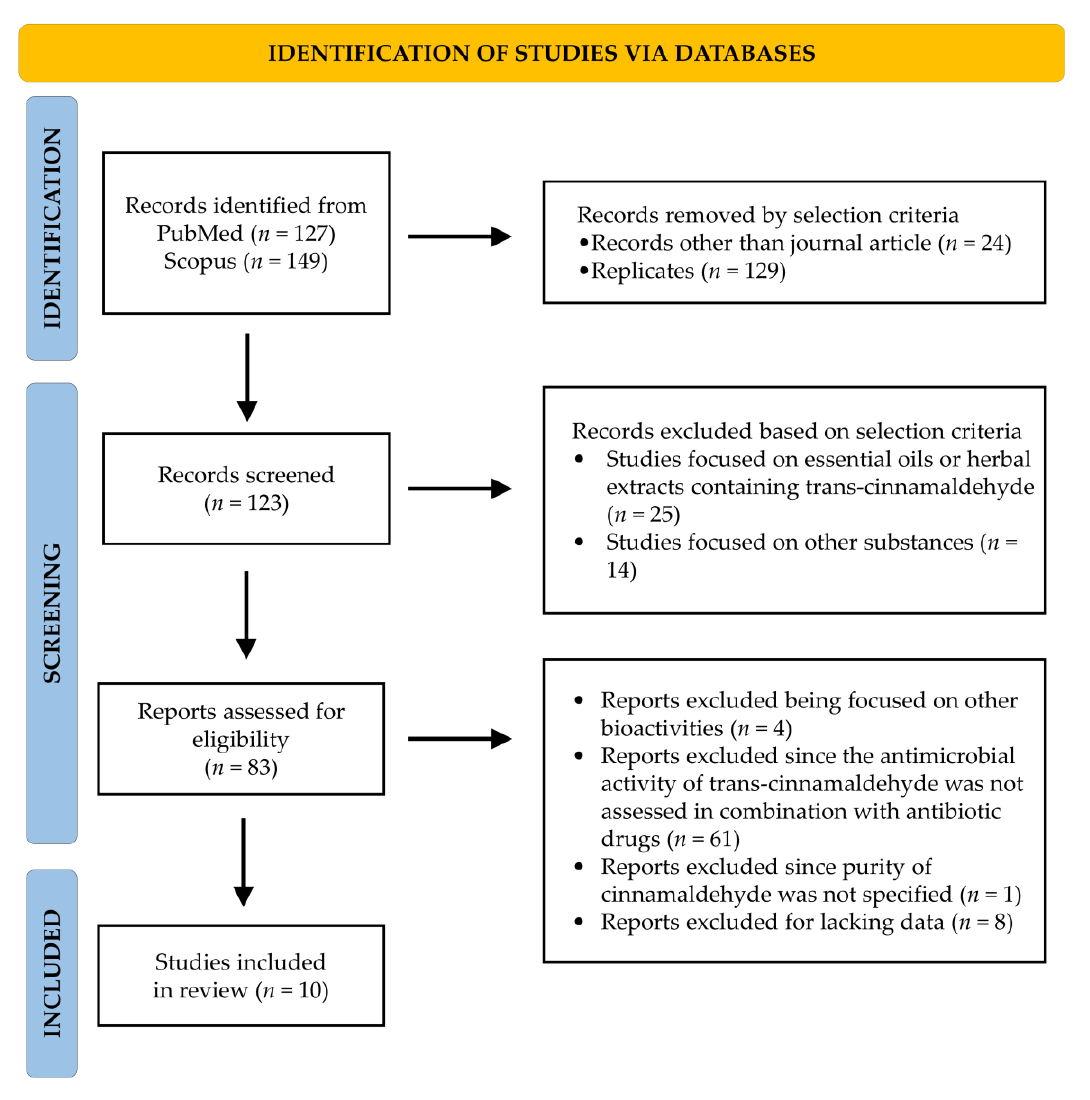
Figure 3. Study selection by PRISMA flow diagram about the ability of cinnamaldehyde to synergize antimicrobial drugs against superbugs.